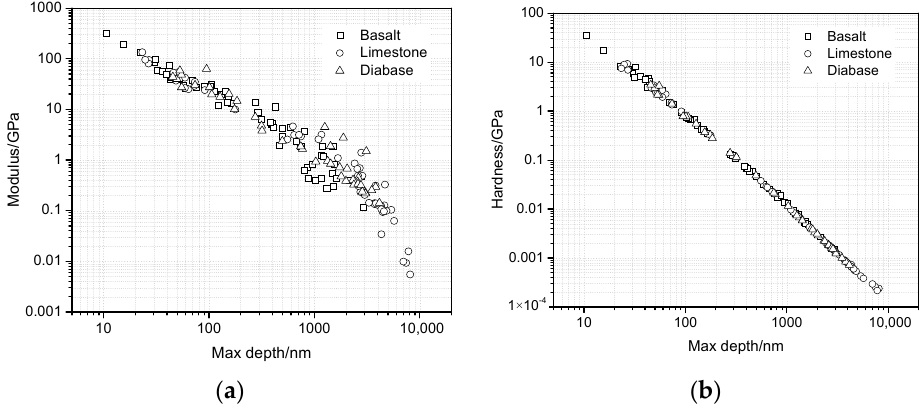
Figure 9. Modulus and hardness versus maximum depth. ( a ) Modulus, ( b ) hardness.